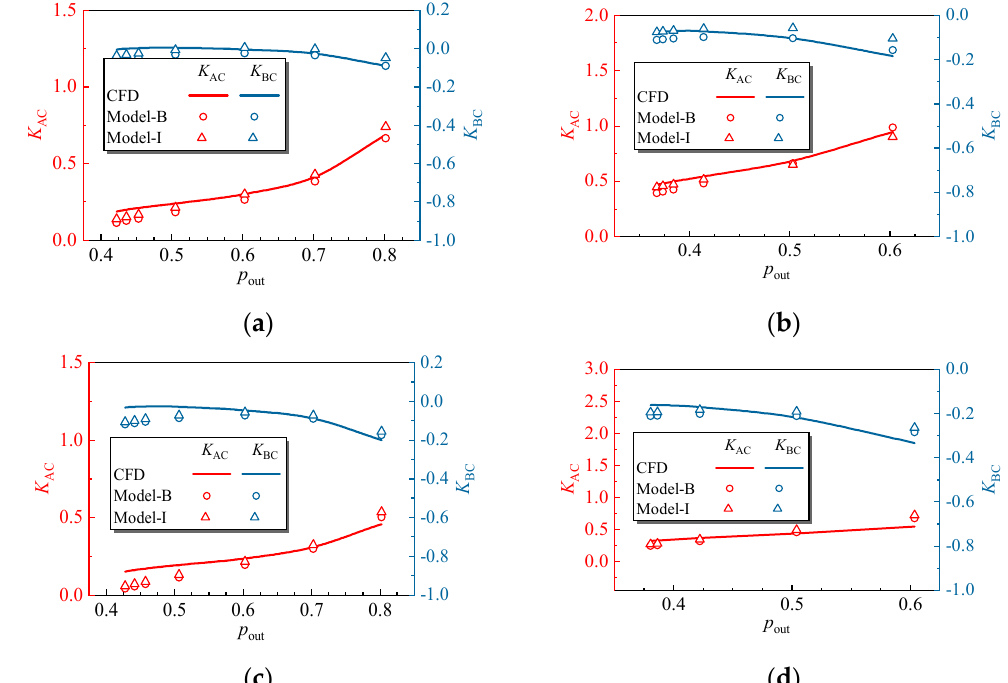
Figure 11. The comparison of the VABI loss characteristics: ( a ) A VABI = 0.4, π = 1.1; ( b ) A VABI = 0.4, π = 1.3; ( c ) A VABI = 0.8, π = 1.1; ( d ) A VABI = 0.8, π = 1.3.